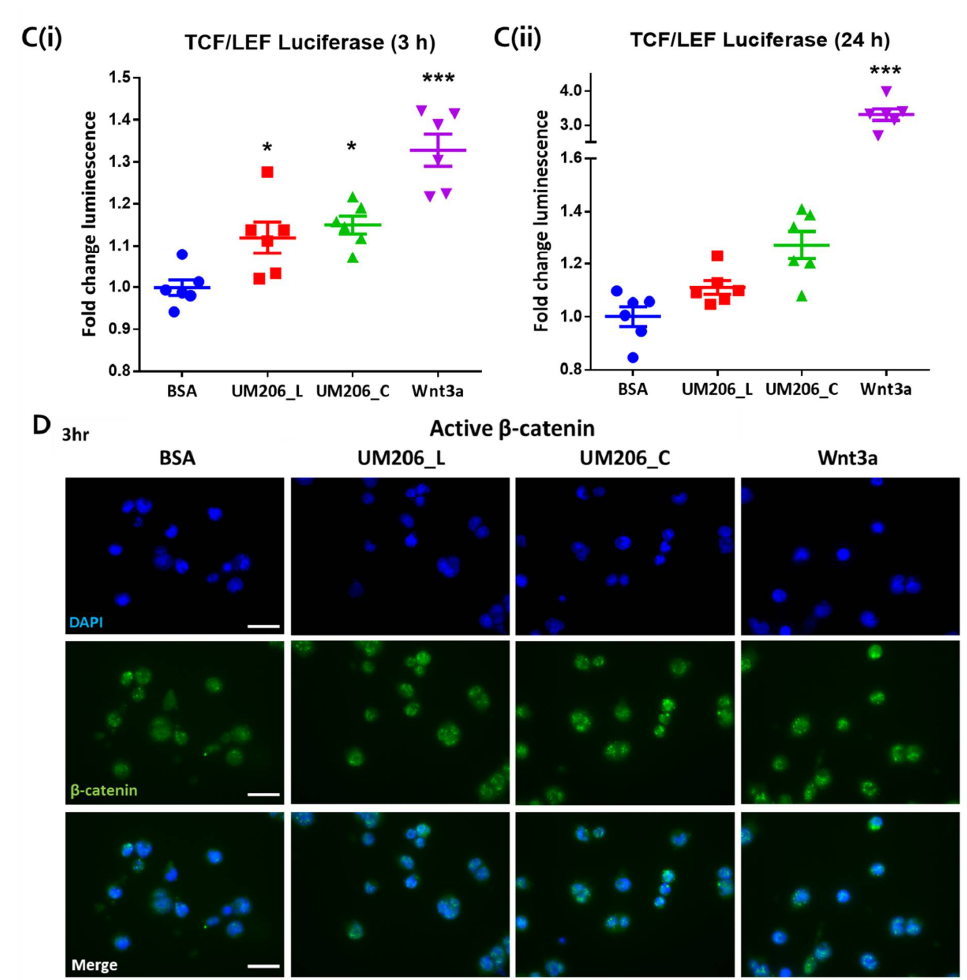
Figure 5. Immobilized UM206 peptide retained mild signaling activity on glass substrate. ( A ) Schematic of UM206 immobilization process onto amine-functionalized glass coverslips using oxygen plasma activation, APTES treatment, then ligand conjugation. ( B ) Fluorescent images of uncoated glass ( left ) and glass substrate coated with antibody-ATTO-488 ( right ) confirmed protein immobilization on glass surface. Bar represents 50 μm, images representative of n = 6. ( C ) HEK293 Luc-TCF/LEF reporter was mildly activated by both immobilized UM206_L and UM206_C to a comparable level as immobilized Wnt3a after 3 h ( C ( i )) but remained at similar levels after 24 h ( C ( ii )). Data are presented as mean fold change ± SEM, n = 6. Shown here are representative results of two independent experiments (* p < 0.05, *** p < 0.001). ( D ) Immunofluorescent images of active β -catenin in response to UM206 functionalized surfaces. A base level of activated β -catenin was observed in the control (BSA) coated group. An increase in activated nuclear β -catenin was observed in response to surfaces coated with UM206_C, UM206_L, or with Wnt3a positive control after 3 h. Representative images of n = 3 shown. Scale bar represents 50 µ